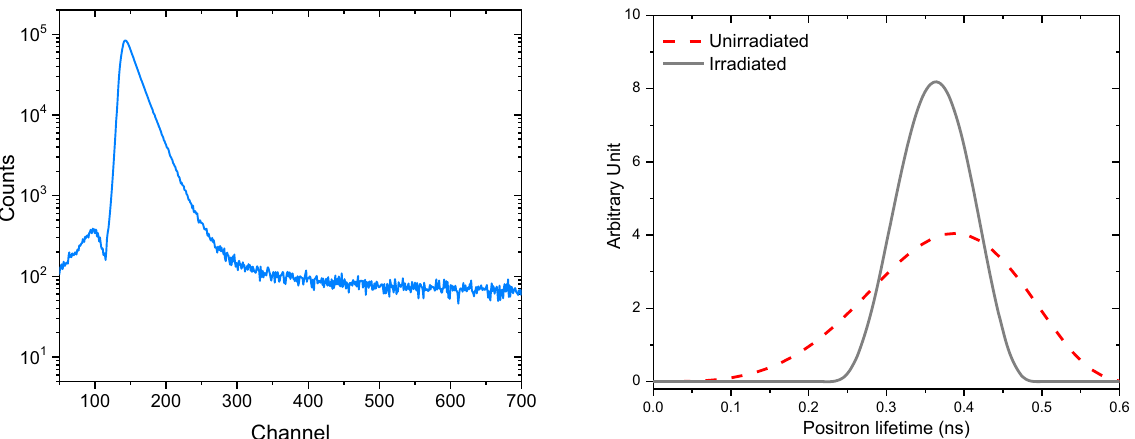
Fig. 5. PALS spectrum (left), and lifetime distribution (right) in nuclear graphite samples